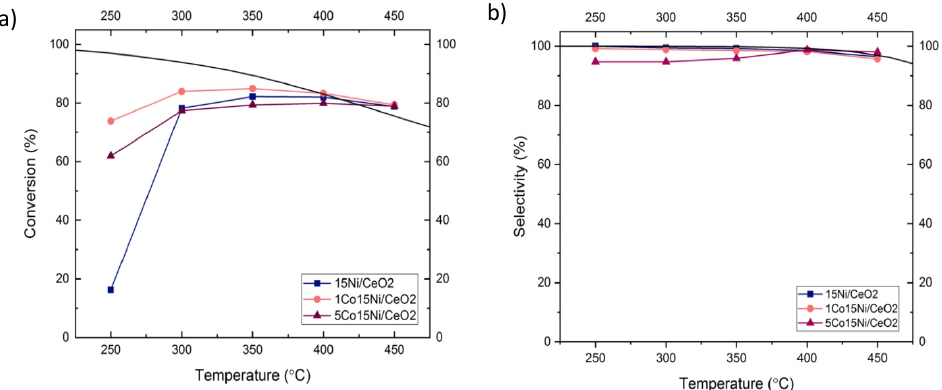
Figure 6. ( a ) Conversion and ( b ) selectivity of Co-Ni/CeO 2 catalyst in thermal CO 2 methanation with different Co loadings.